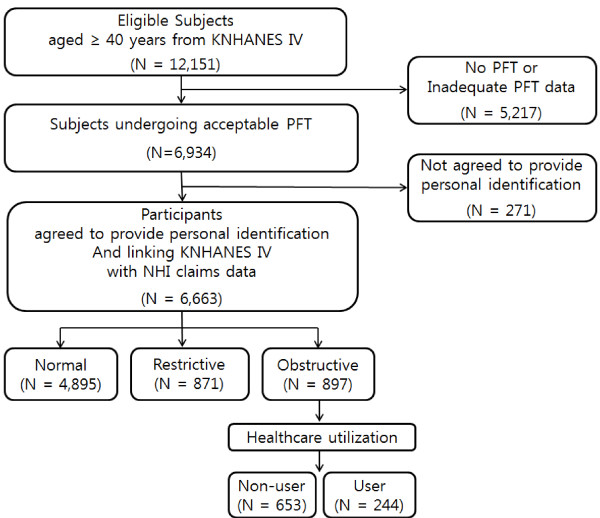
Flow chart for selection of study participants. PFT = pulmonary function test; Normal = FEV1/FVC ≥ 70% and FEV1 ≥ 80% predicted; Restrictive = FEV1/FVC ≥ 70% and FEV1 < 80% predicted; Obstructive = FEV1/FVC < 70%; Non-user = person who did not use healthcare resources at all with first-listed and secondary diagnosis of COPD; User = person who used any kind of healthcare resource with first-listed and secondary diagnosis of COPD.